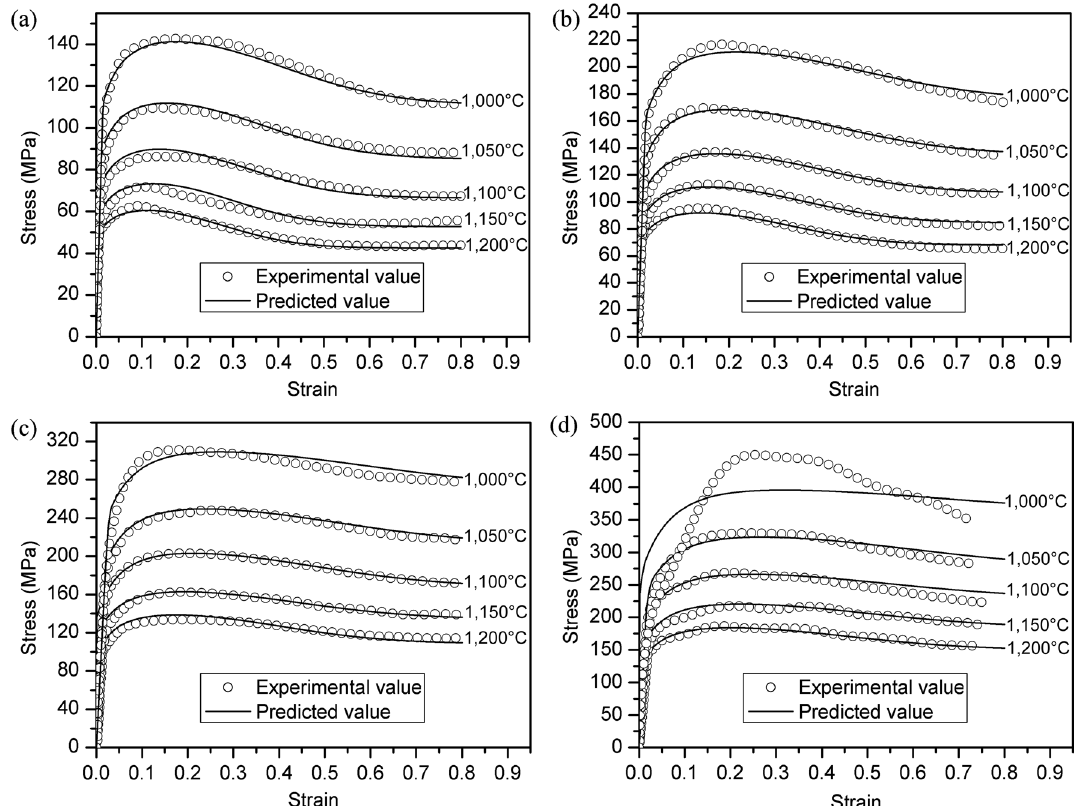
Figure 10: Comparisons between experimental flow stress of Nimonic 80A and predicted ones at various temperatures with strain rates of (a) 0.01 s – 1 , (b) 0.1 s – 1 , (c) 1 s – 1 , (d) 5 s – 1